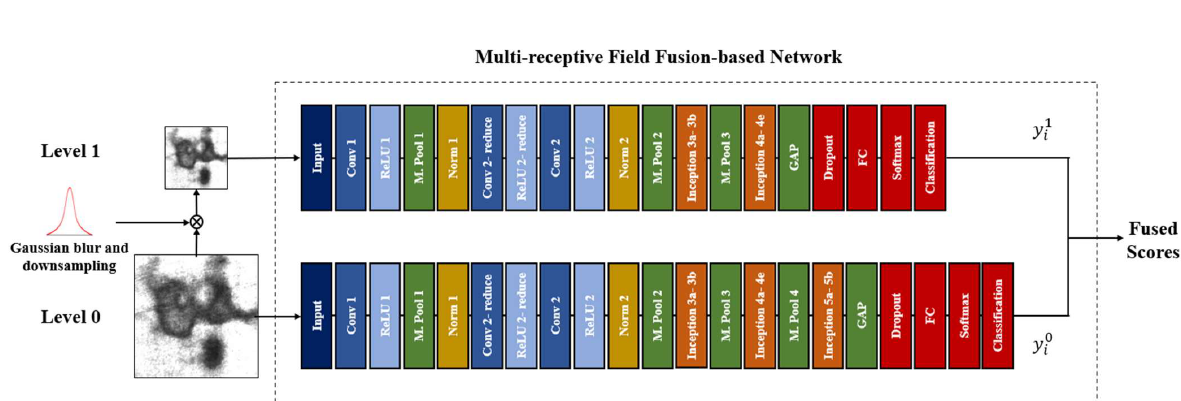
Figure 3. The overall framework of the proposed method. First, the original images are decomposed by the Gaussian pyramid. Then, level 0 and level 1 are trained individually by the low-level and high-level images. Lastly, the confidence scores of both networks are fused to obtain the final